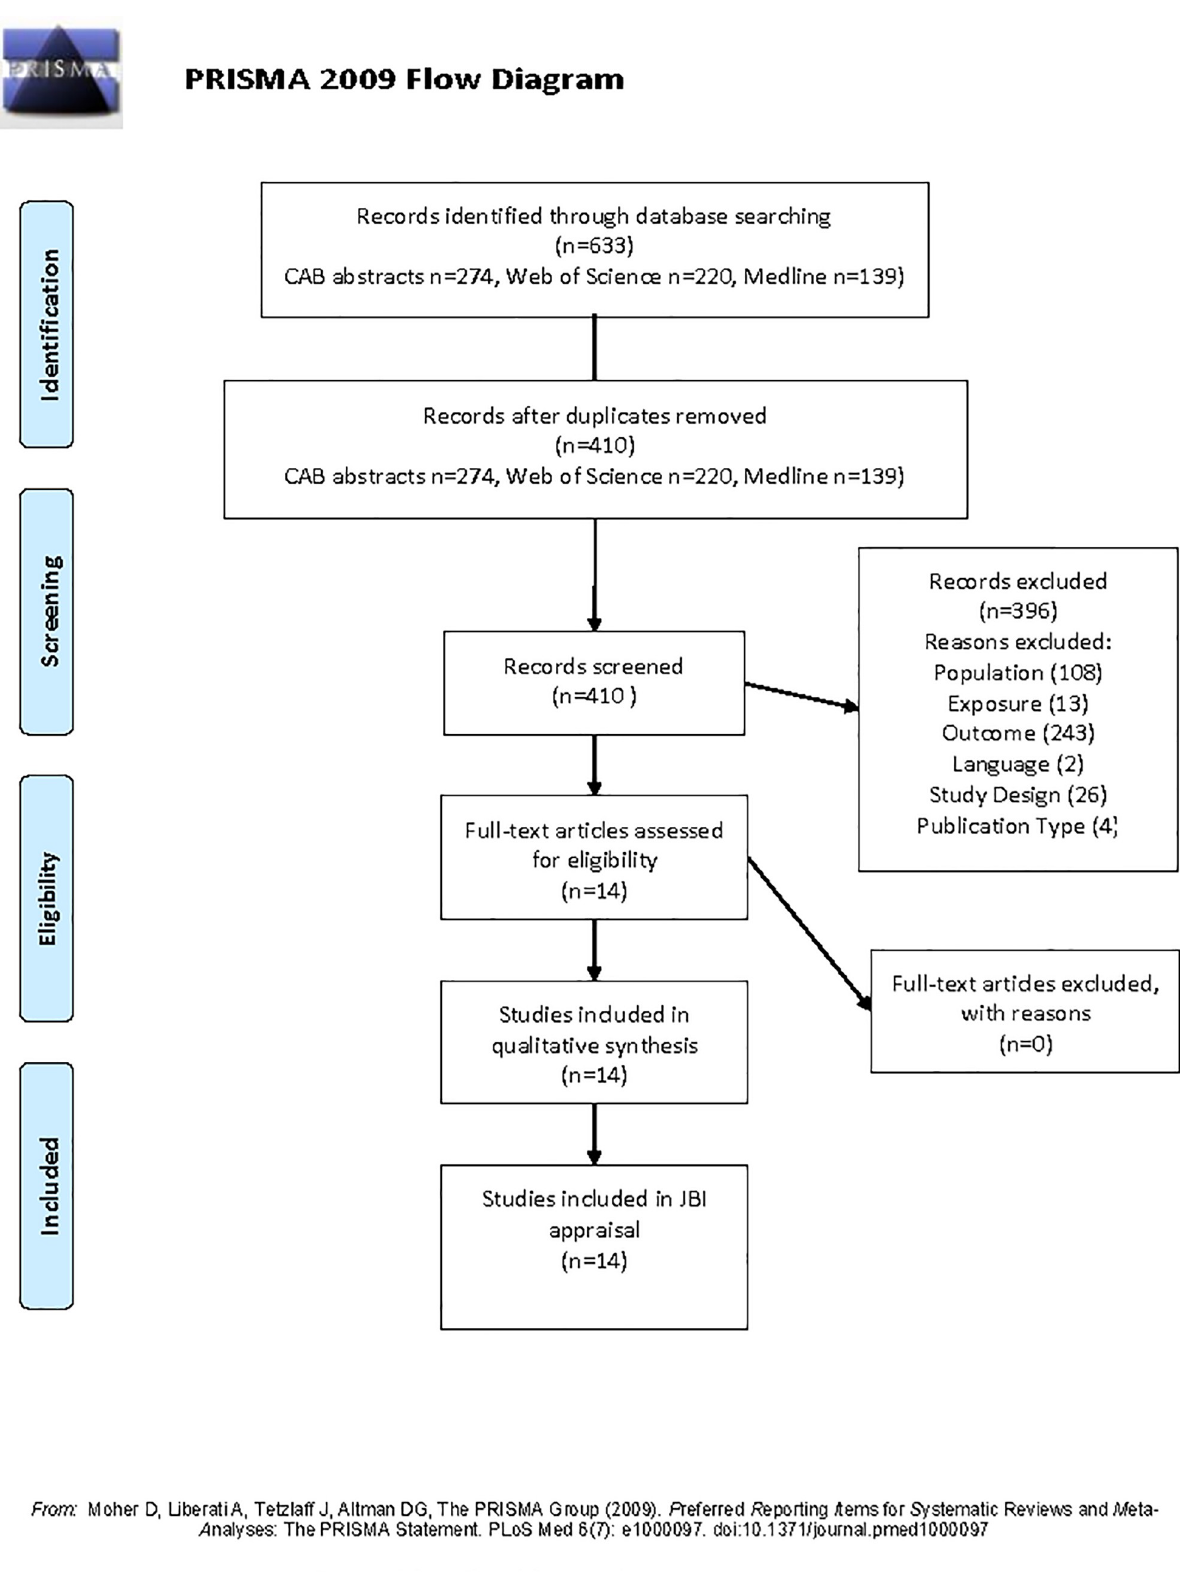
Fig 2. PRISMA 2009 flow diagram for the numbers of studies identified, screened, assessed for eligibility, and included in a systematic review of the risk factors for colic relating to management change. https://doi.org/10.1371/journal.pone.0219307.g002 PLOS ONE | https://doi.org/10.1371/journal.pone.0219307 July 11,